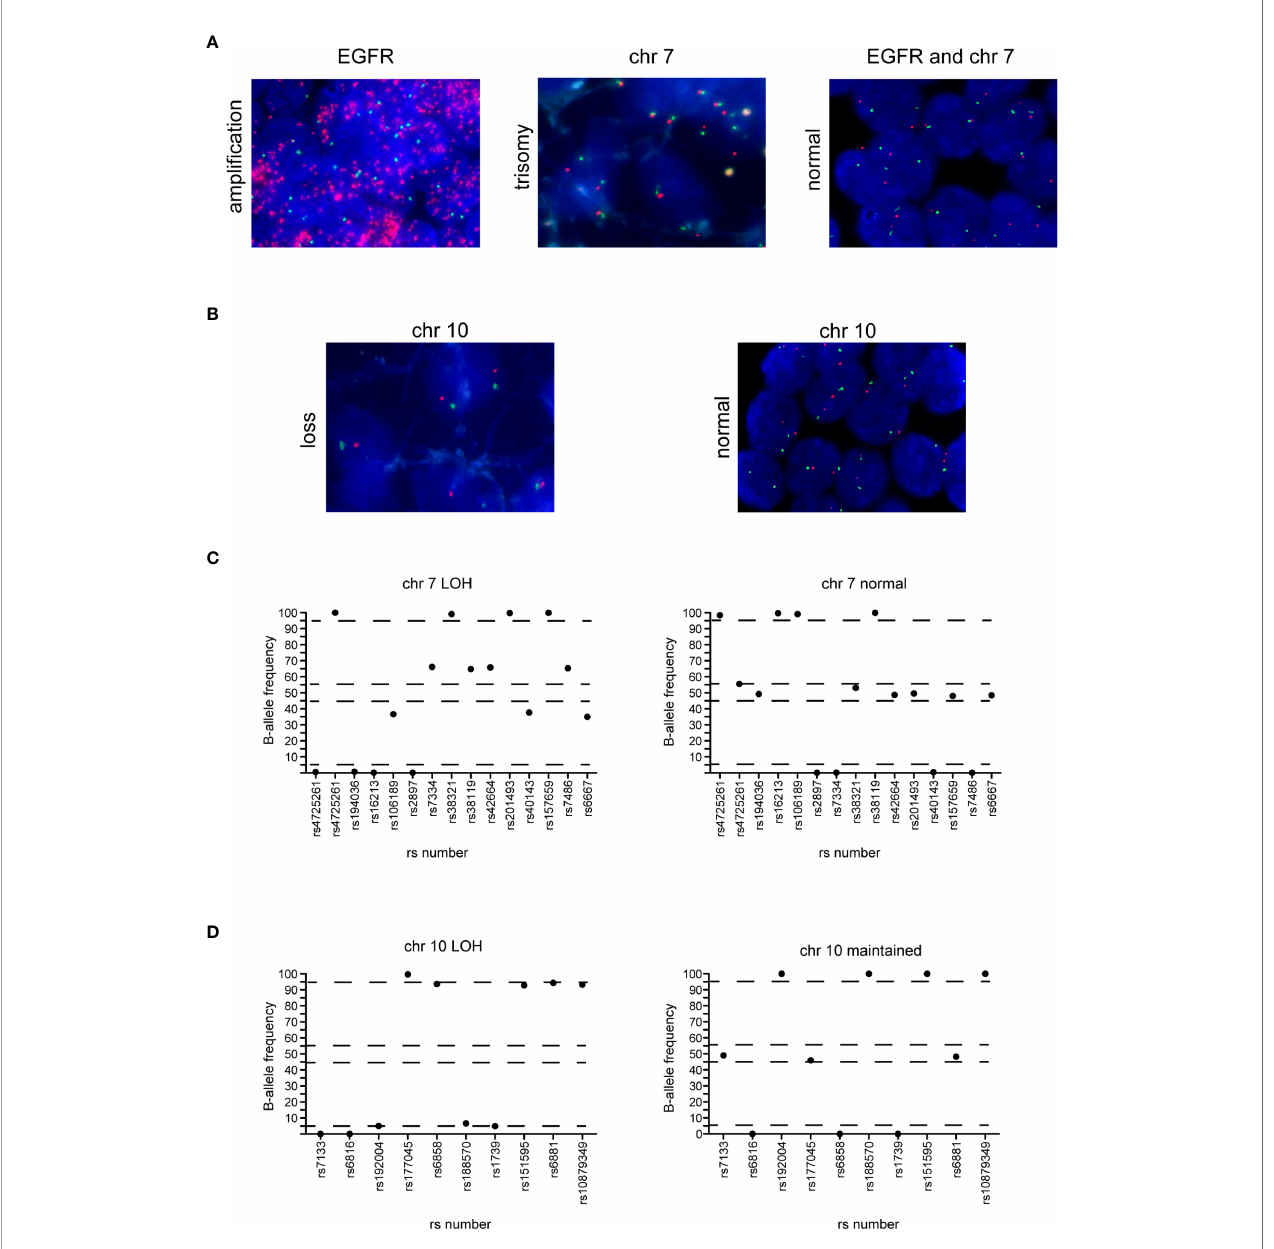
FIGURE 5 | Correlation between FISH and NGS detection of EGFR ampli fi cation, chromosome 7 gain and chromosome 10 loss. (A) EGFR ampli fi cation (left panel) and trisomy of chromosome 7 (middle panel) in two cases of GBM and normal EGFR expression and chromosome 7 (right panel) in a case of astrocytoma detected by FISH. Red dots represent the EGFR gene while green dots represent the centromere of chromosome 7. (B) Chromosome 10 loss (left panel) and negative control (right panel) in two glioma samples. Red dots represent 10q23 signal while green dots represent the CEP 10 signal. (C) Distribution of B-allele frequencies based on LOH of SNPs of a GBM sample with typical chromosome 7 gain (left panel) and an astrocytoma sample without chromosome 7 gain (right panel). (D) Distribution of B-allele frequencies based on LOH of a GBM sample showing chromosome 10 loss (left panel) and a sample without LOH of chromosome 10 (right panel). The x axis shows the investigated SNPs (rs number was reported) and the y axis shows the percentage variant (B-allele frequency). Dashed lines indicate the arbitrarily set homozygosis range of 0 - 5% and 95 - 100%. The range of heterozygosis is de fi ned as being between 45% and 60% of B-allele frequency. LOH was called as indicated in the legend of Figure 4